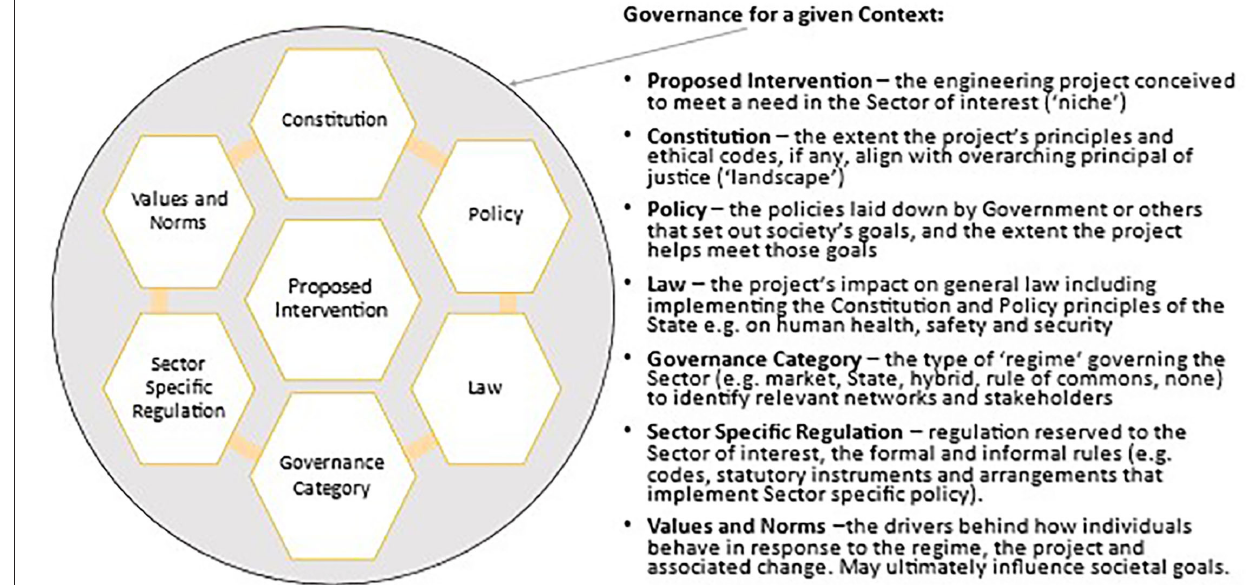
FIGURE 1 | Forms of governance.